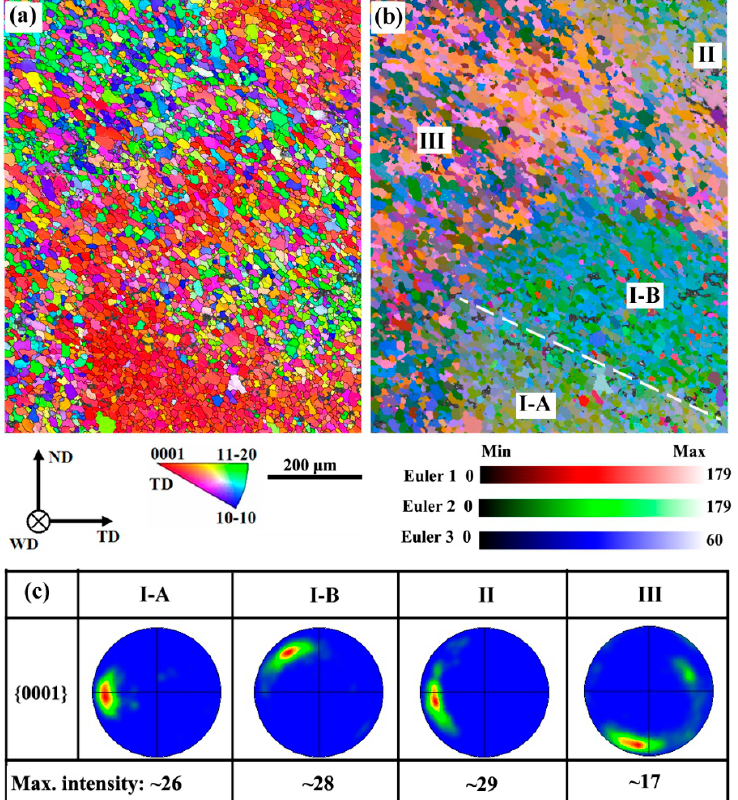
Figure 6. EBSD orientation maps of triple junction region in FSW AZ31 alloy: ( a ) IPF map; ( b ) Euler angle map; and ( c ) texture distributions [85].